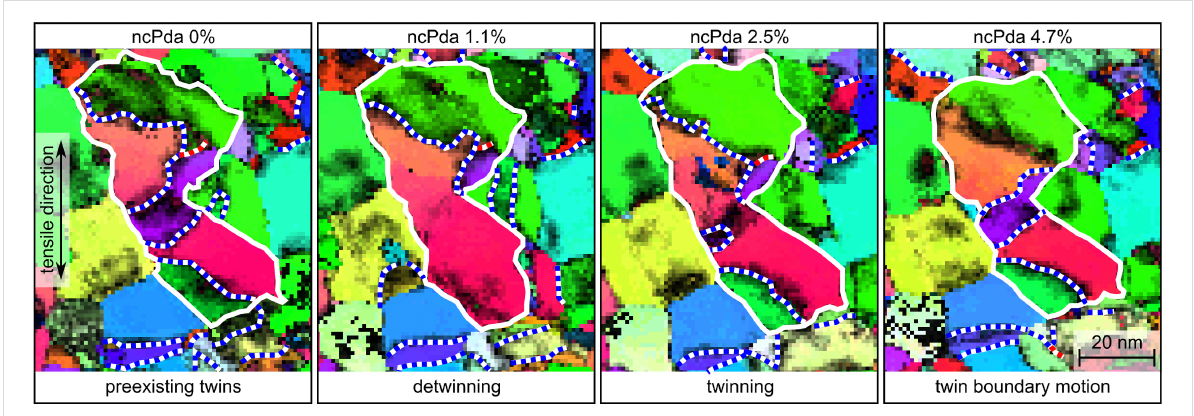
Figure 3: Twinning, twin boundary migration and detwinning of the center grain (white boundary) during the tensile deformation (0-4.7% strain) of ncPda. The ACOM-STEM orientation maps overlaid with the reliability are shown for selected straining states with the projection direction along the tensile direction and the color code is given in Figure 1c. The Σ 3 disorientations are marked with white/blue dashed lines and the Σ 9 disorientations with white/red dashed